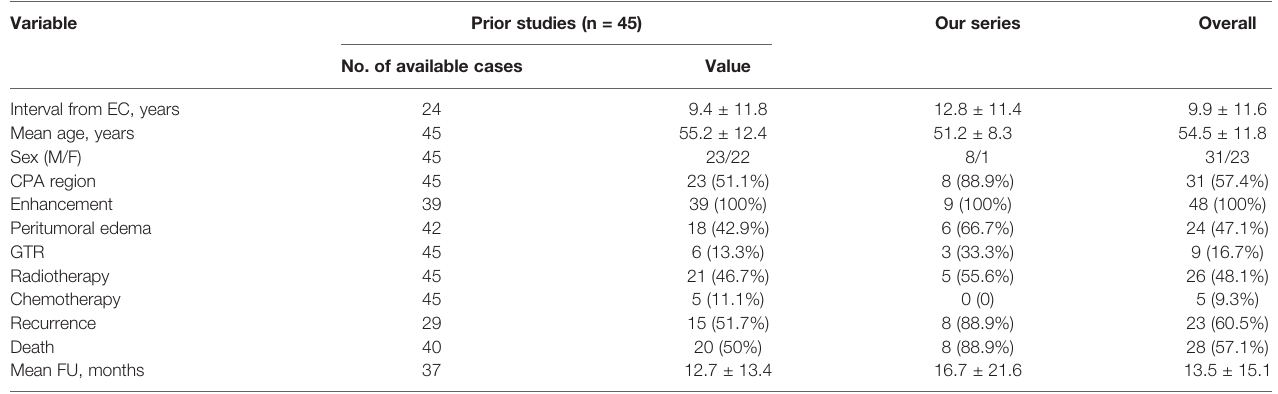
TABLE 3 | Summary of clinical characteristics of PSCCs arising in IECs from literature and our institute.